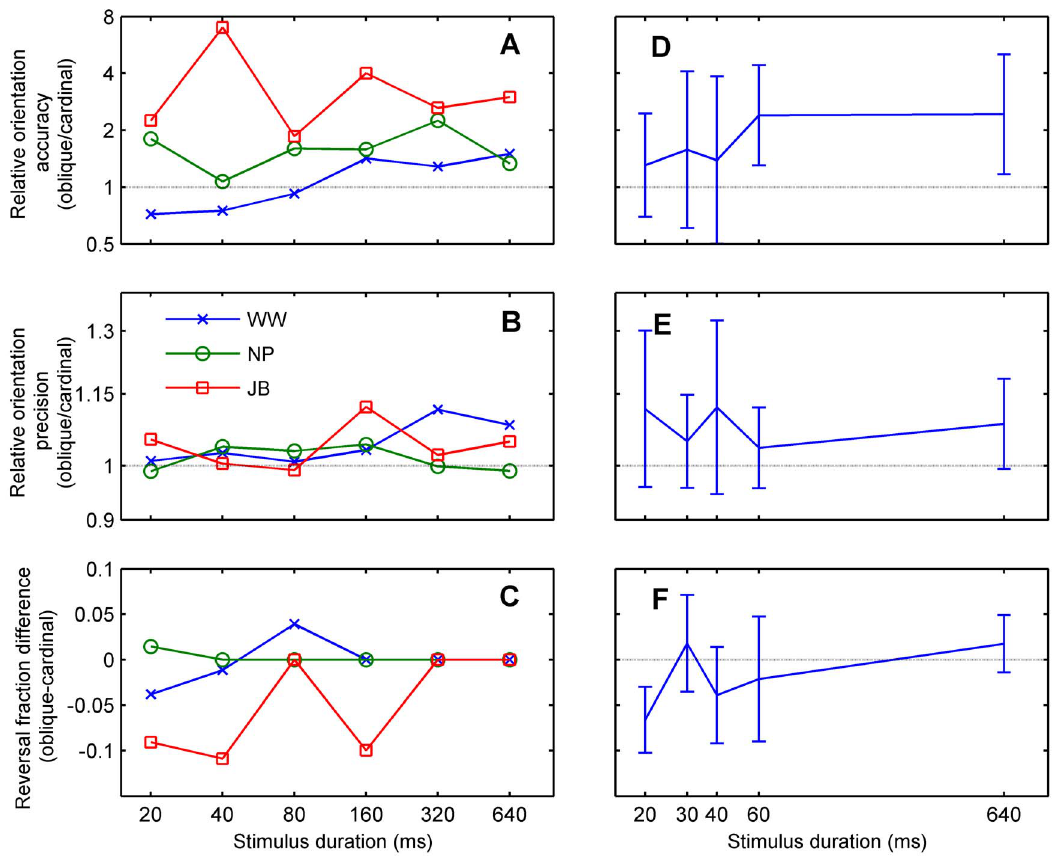
Figure 9. Relative performance for oblique versus cardinal directions. As in Figure 8, results are shown separately for three experienced observers (A–C) and averaged across eleven participants (D–F; mean 6 SD ). The ratio of oblique to cardinal orientation accuracy (A, D) and precision (B, E) was used to measure the strength of the oblique effect. Values greater than 1 indicate that orientation performance was better for cardinal directions than obliques. Error bars show geometric standard deviation. (C, F) The difference between arcsine-transformed oblique and cardinal reversal fractions; values greater than 0 indicate that direction performance was better for cardinal directions than obliques.